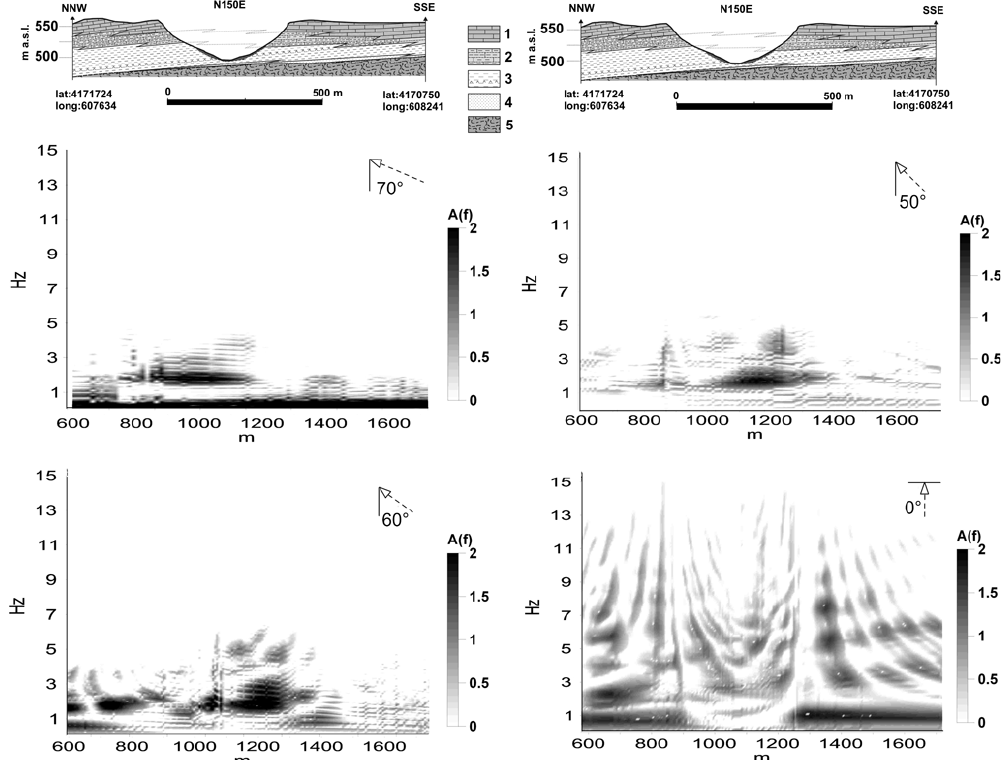
Fig. 7. A(f ) functions obtained by the 2-D numerical modeling of the seismic wave propagation with different incidence angles (i.e. 0 ◦ , 50 ◦ . 60 ◦ and 70 ◦ , respectively). Legend: (1) Calcarenites; (2) Calcarenites-marls; (3) Marls with gypsum levels to the base; (4) Sands and conglomerates; (5) Triassic